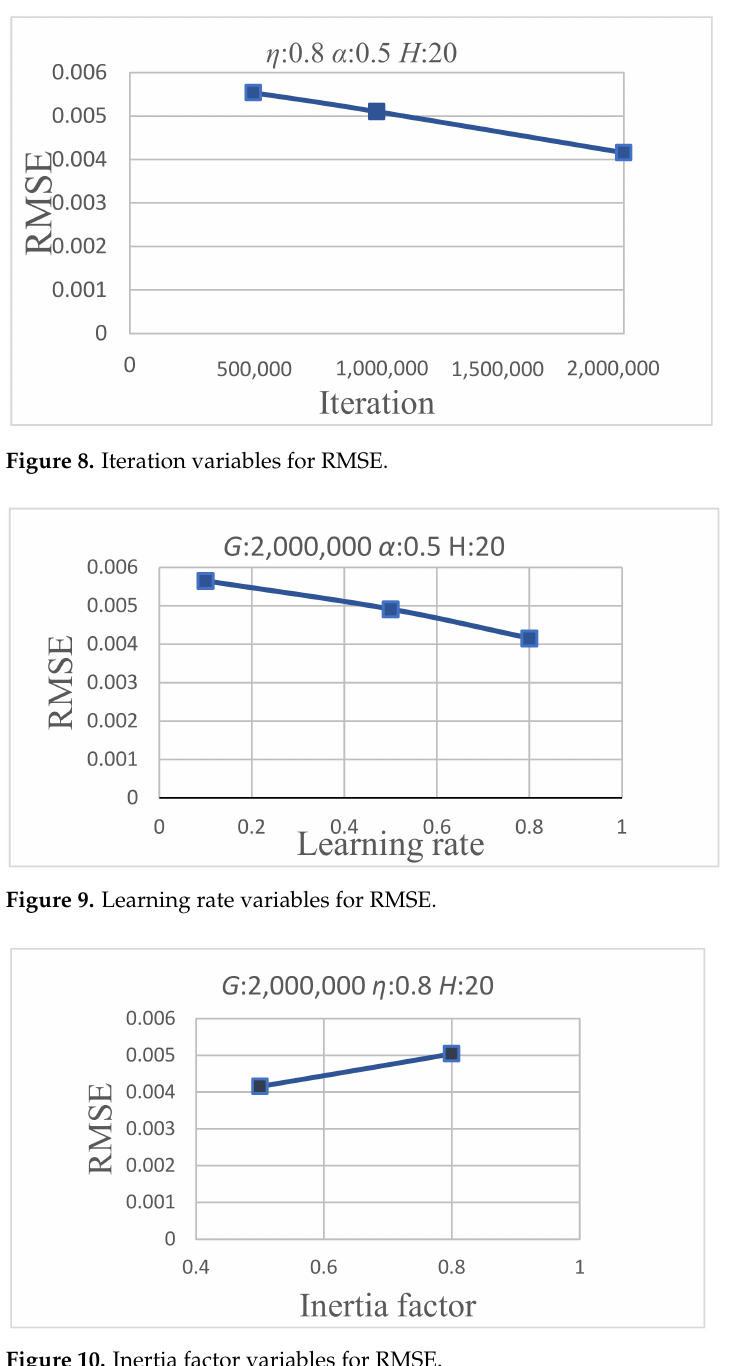
Figure 10. Inertia factor variables for